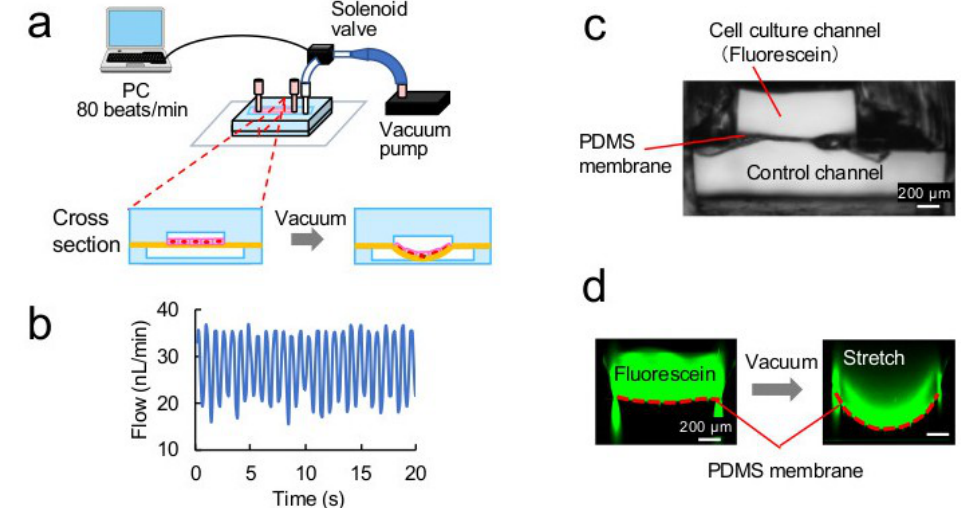
Figure 2. System setup and stretching properties. ( a ) An illustration of the system. The control channel was connected to a computer-controlled solenoid valve and an air pump. ( b ) Flow rate at the upper cell culture channel outlet in the stretch system was set at 80 beats/min, the same frequency as the heartbeat of the patient. ( c ) Photograph of a cross-section of the microdevice. The upper channel was 1 mm wide and the lower channel was 2 mm wide. ( d ) A cross-sectional image of the channels reconstituted from a confocal microscope image. The extension ratio of the PDMS membrane was estimated at 30%.